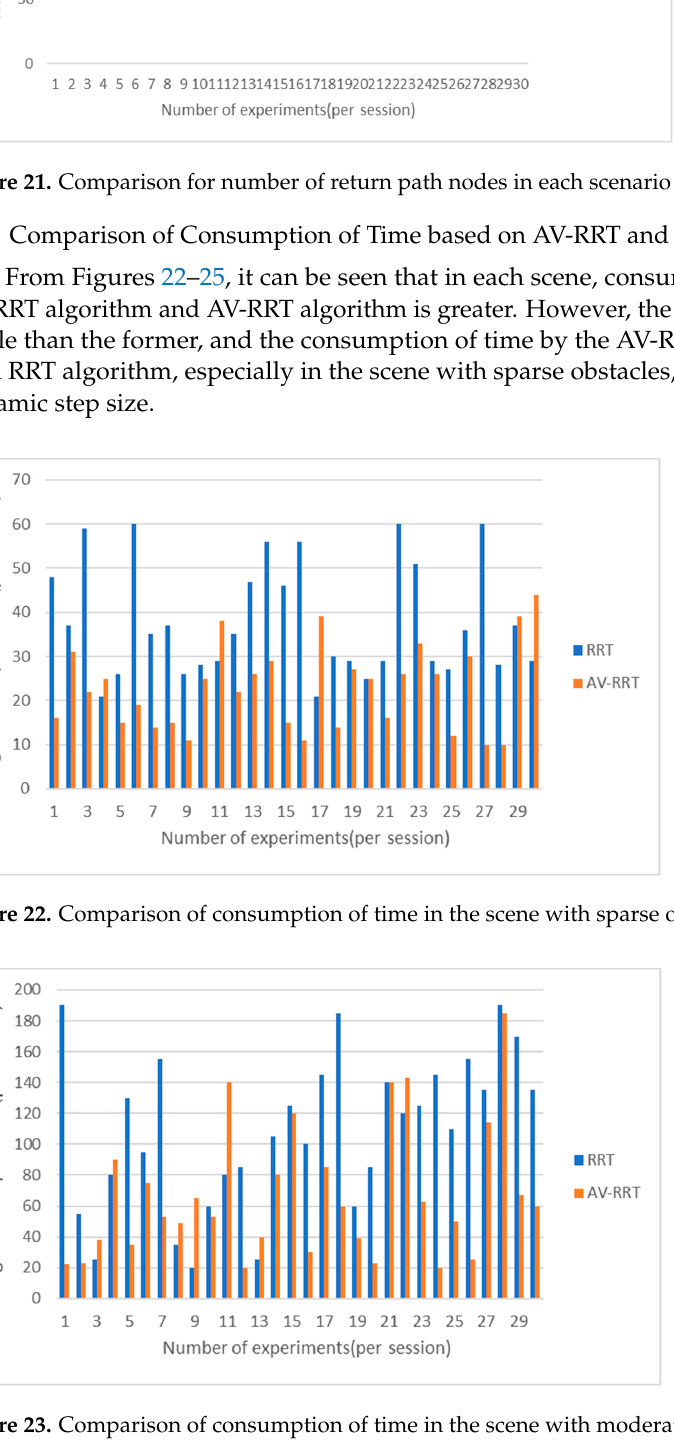
Figure 24. Comparison of consumption of time in the scene with dense obstacles. Figure 25. Comparison of consumption of time in each scenario with the AV-RRT algorithm. Based on the simulation experimental data in the above three scenarios, it is con- cluded that the AV-RRT algorithm has a higher performance than the basic RRT algorithm in terms of node expansion times in space, number of nodes included in the planned path, and path planning time consumption, and this advantage is more prominent in sparse obstacle scenarios.